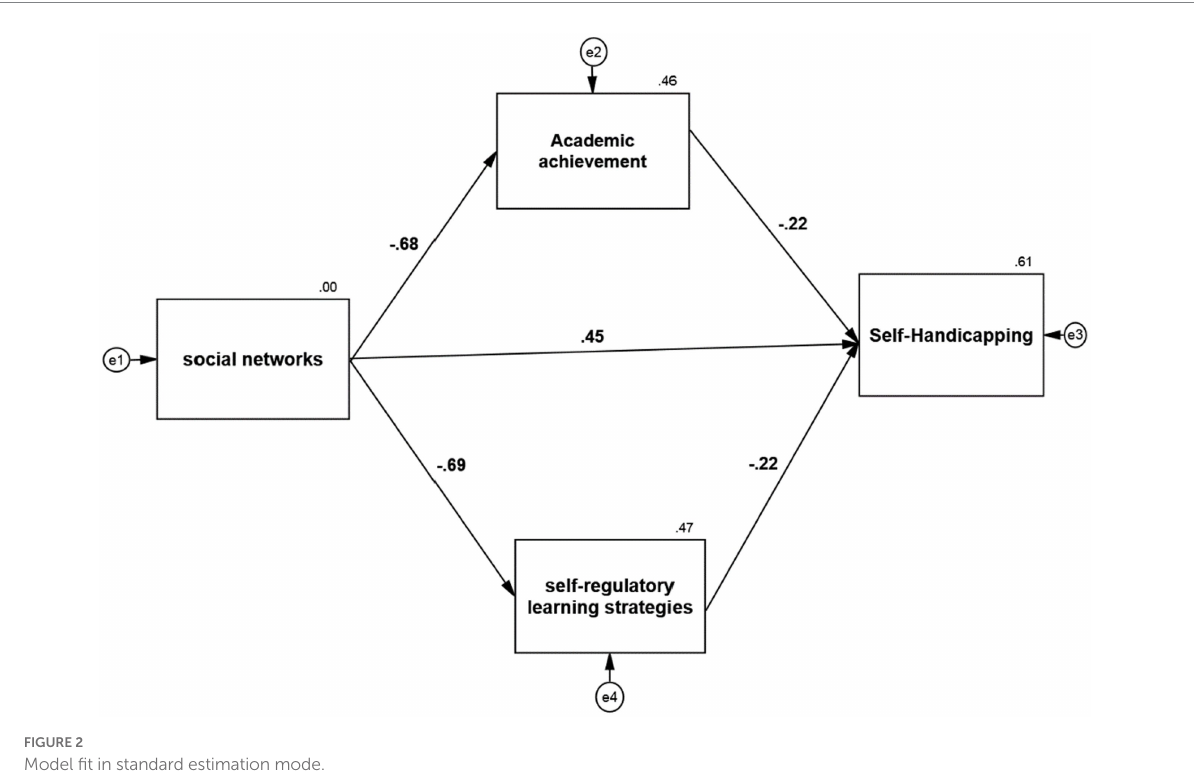
FIGURE 2 Model fit in standard estimation mode.